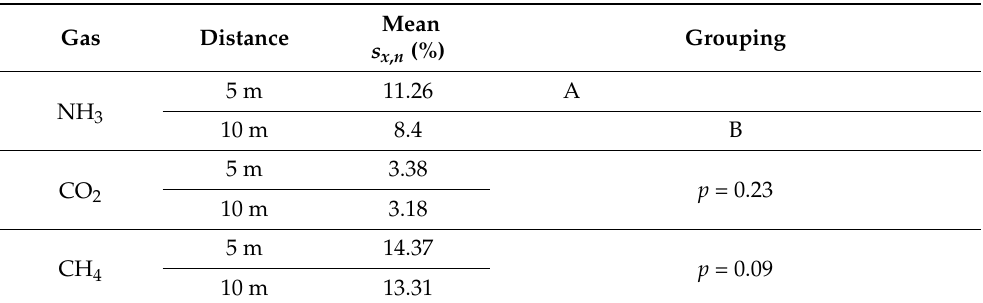
Table 3. Results of the variability ε i in relation to the distance of the two sampling locations considered, and outcomes of post hoc analysis (Tukey